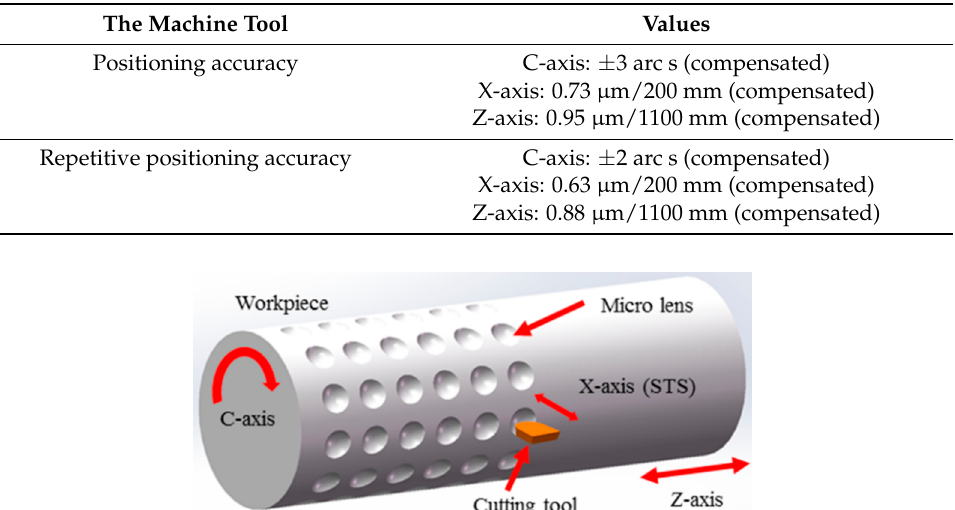
Figure 5. Experimental setup for the machining process. Table 1. Specification of the machine tool.